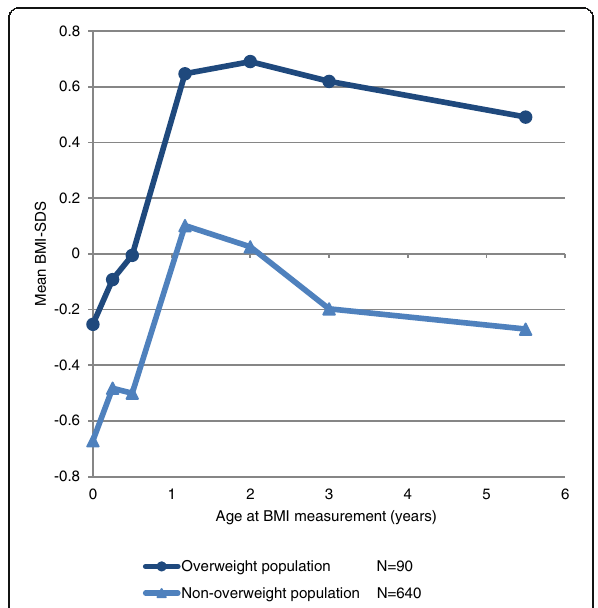
Fig. 1 Mean BMI-SDS at ages 0 to 6 years of overweight and non- overweight 10-year-old children